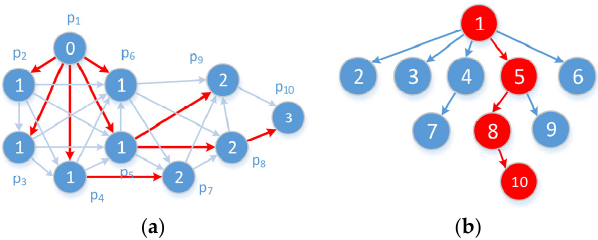
Figure 5. ( a ) The process of the breadth-first search. ( b ) The breadth-first spanning tree.